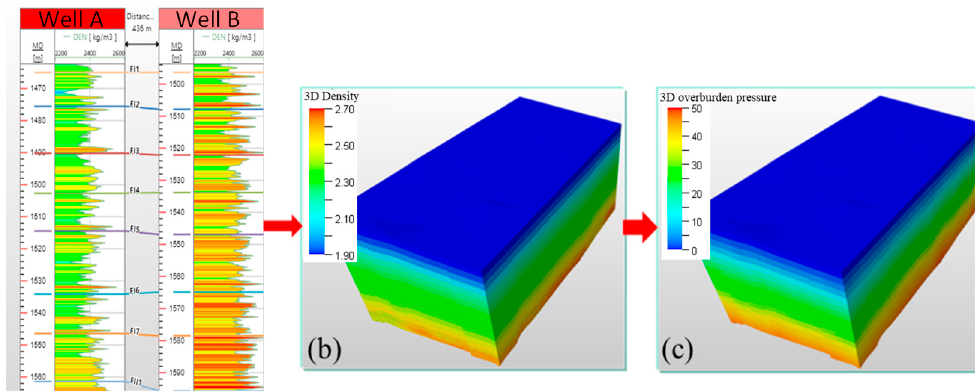
Figure 4. Overburden pressure modeling workflow. ( a ) Single-well density curve; ( b ) 3D density model; ( c ) 3D overburden pressure model. model; ( c ) 3D overburden pressure